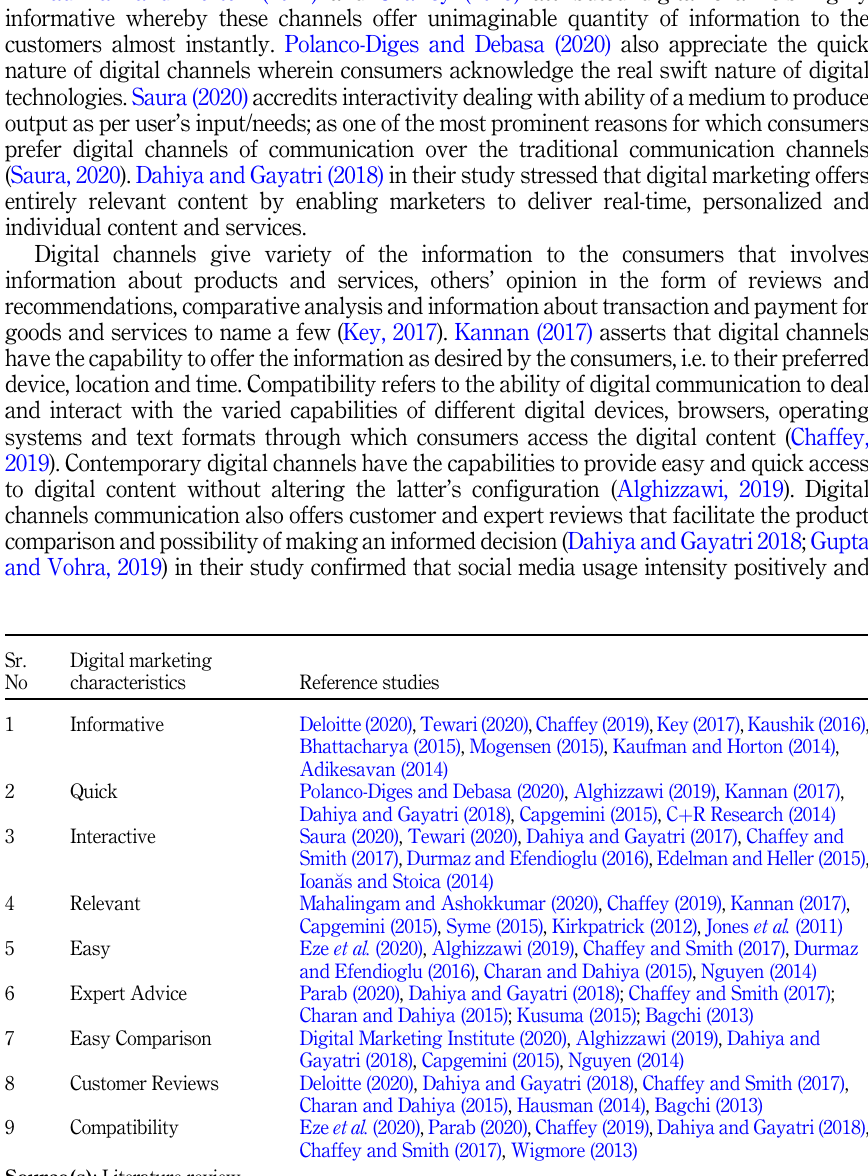
for construction of